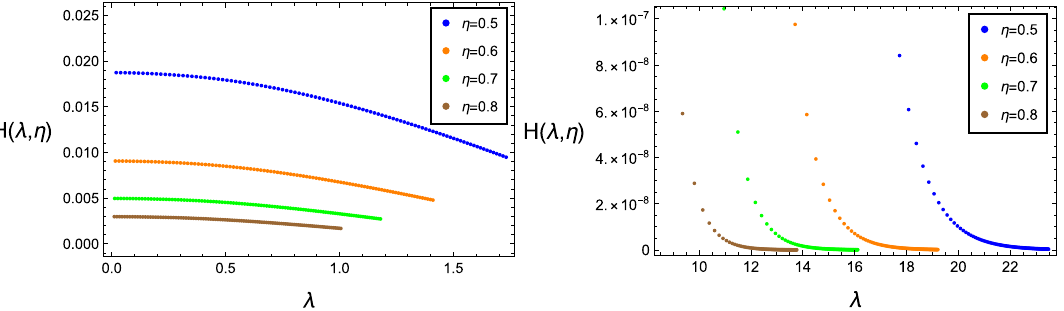
Fig. 2 The left panel shows the causal horizon entropy for z (cid:12) 1 (UV behavior), while the right panel for z (cid:13) 1 (IR behavior). The horizontal axes of both panels are the affine parameter λ . We have set the parameters, m = 0 . 1, e = 0 . 5, and (cid:9) AdS = 0 . 1, for the convenience of numerical calculations and